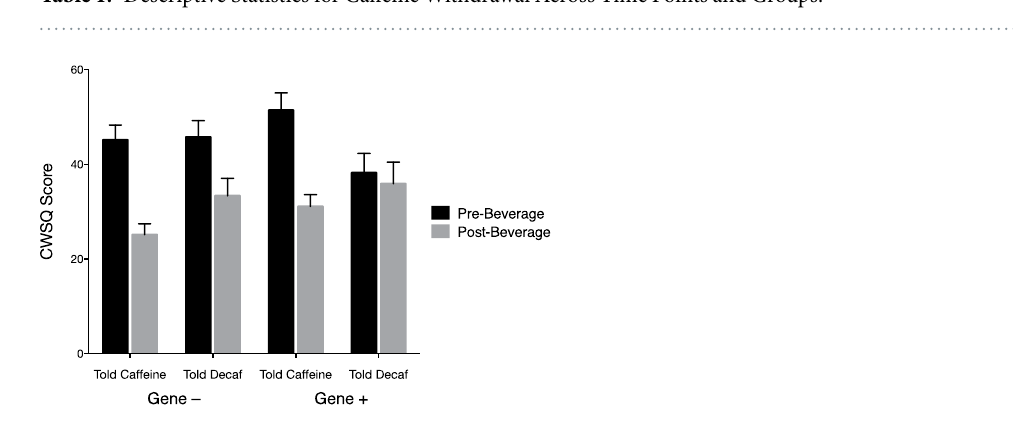
three factors, along with Baseline CWSQ score (4) and duration in days between delivery of ‘results’ and test (5), were entered as covariates in the mixed ANCOVA. The primary outcome variable was total score on the CWSQ, however analysis of RVIP scores and blood-pressure were also conducted. Assumptions tests performed on both Pre- and Post-Beverage CWSQ scores indicated normality (Shapiro-Wilks test; Pre: W = 0.99, p = 0.82; Post: W = 0.97, p = 0.09) and homogeneity of variance (Kruskal-Wallis test on four experimental groups: Pre: χ 2 Effect of Priming and Caffeine Information on Withdrawal Symptoms. Mean CWSQ scores across time points and groups are presented in Table 1. Figure 2 shows mean Pre- and Post-Beverage CWSQ scores across groups and Fig. 3 shows the main effects of Priming and Caffeine Information.